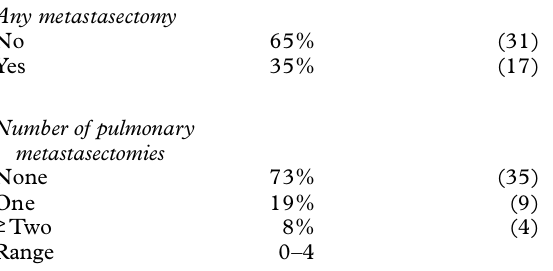
Table 3 . Surgical treatment of metastatic tumor sites in 48 patients with soft tissue sarcomas and synchronous metastases